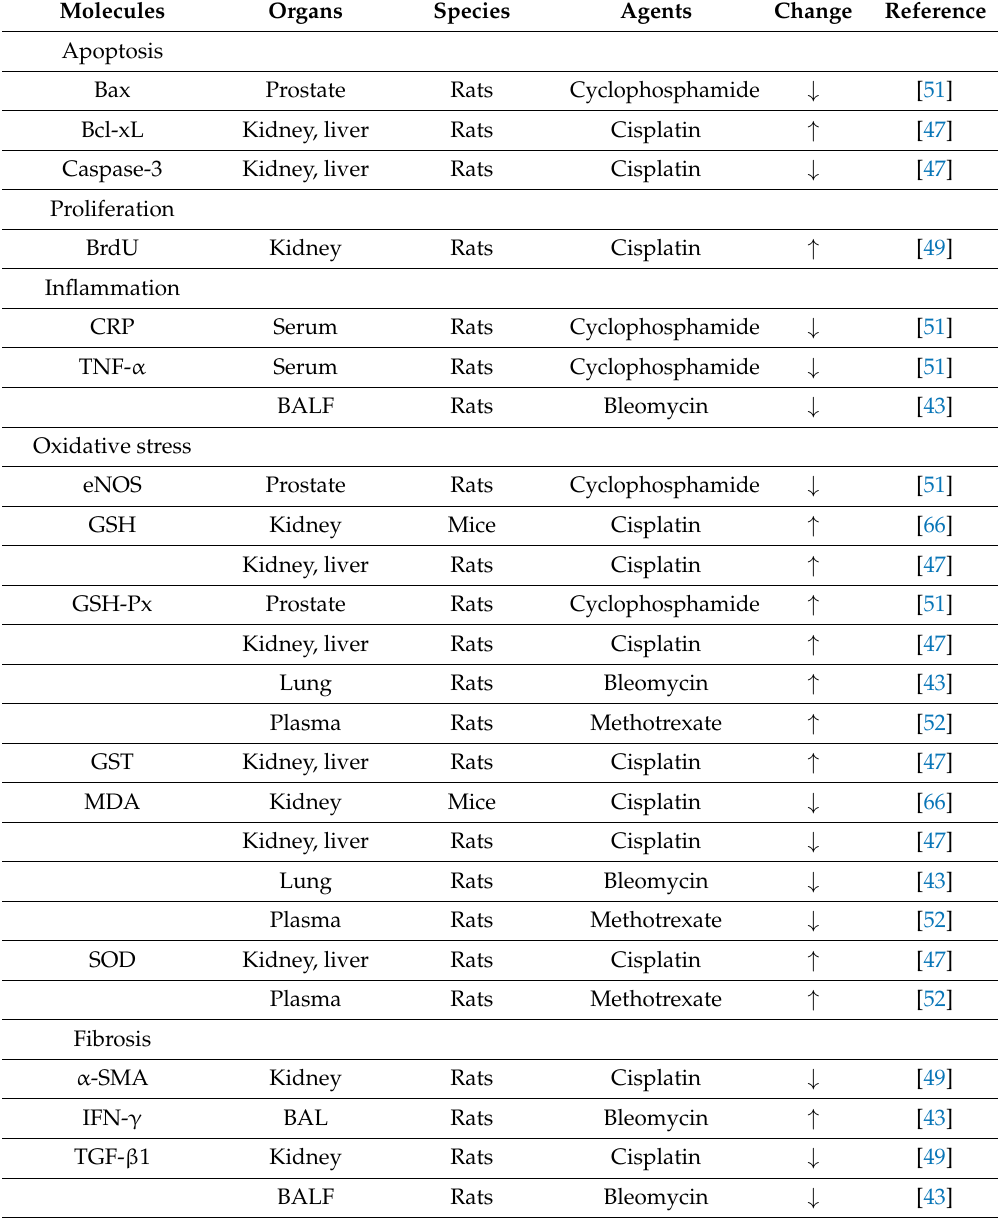
Table 2. Molecular-level changes induced by royal jelly in response to anti-cancer therapies.